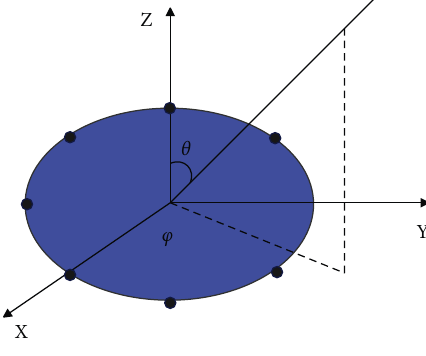
Figure 6: Uniform circular array